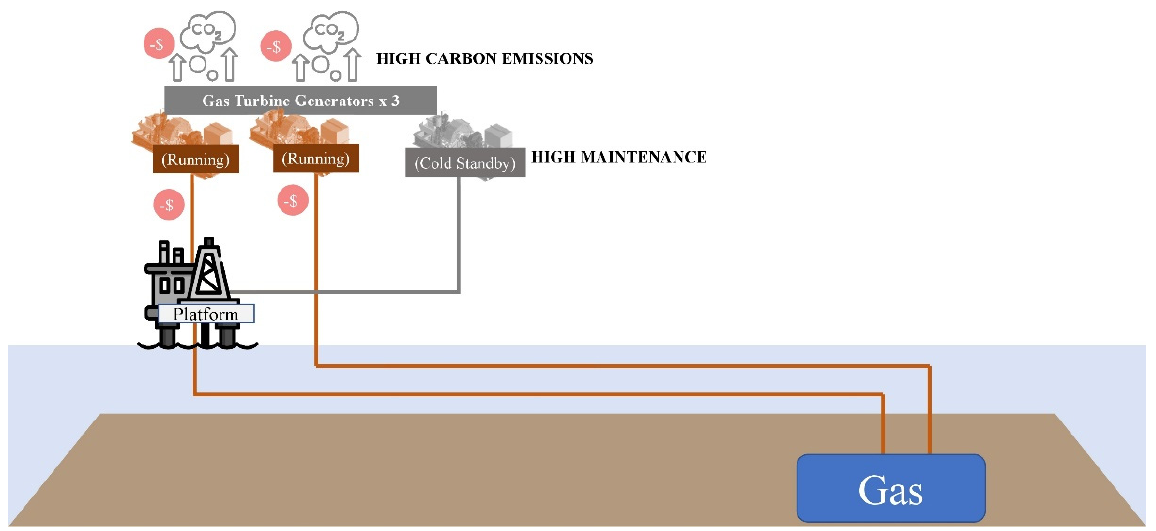
Figure 1. Conventional power generation concept.